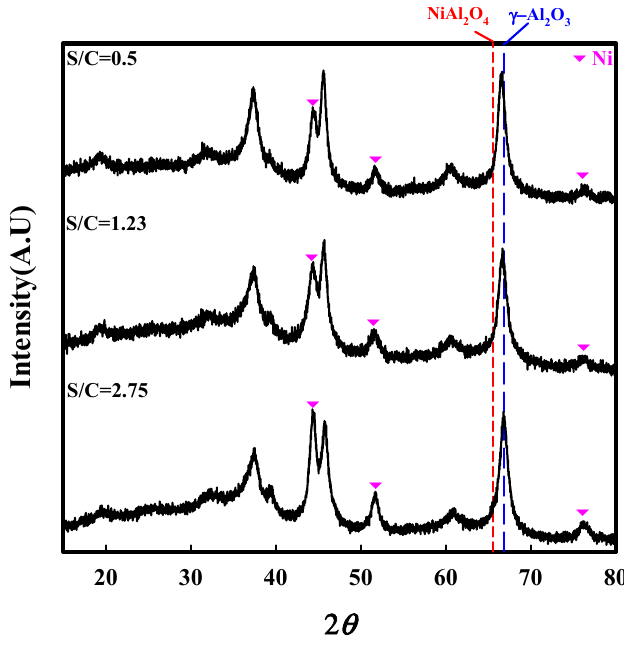
Figure 7. XRD patterns of auto-reduced NA10-PM catalyst after reaction at various S/C ratios for 5 h under O 2 /C = 0.25, and GHSV = 12,000 h − 1 at 750 °C.